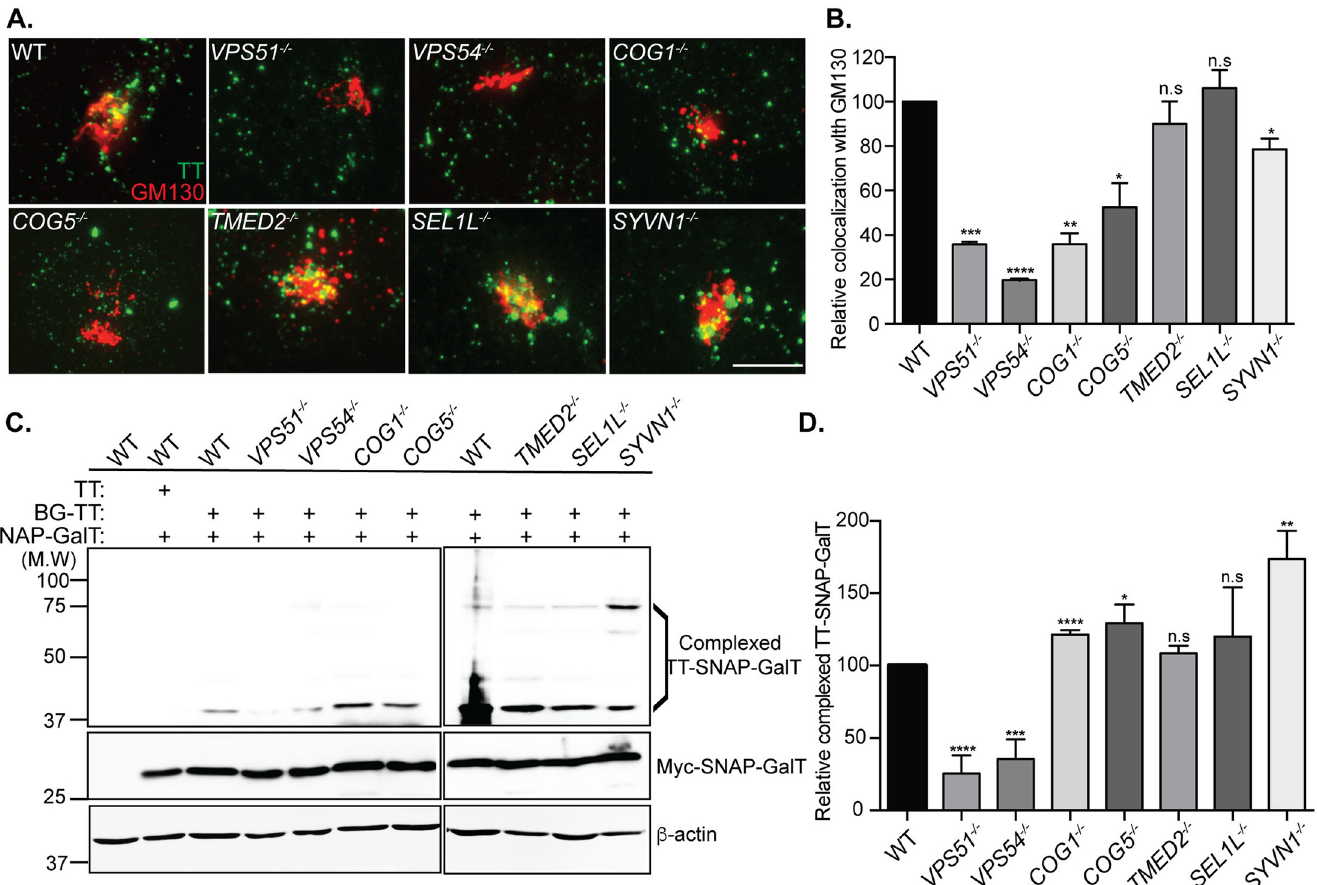
Fig 4. Characterization of typhoid toxin trafficking to the TGN in CRISPR/Cas9-edited cell lines. (A and B) Co-localization of typhoid toxin with the Golgi marker GM130. (A) Wild-type and the indicated knockout cell lines were treated with Oregon-488 labeled typhoid toxin (green) and 2 hours after toxin treatment, cells were stained with an anti-GM130 antibody (red) as described in Material and Methods. Scale bar, 5 μ m. (B) The co-localization between typhoid toxin and GM130 was determined as described in Material and Methods. Values represent the relative co-localization (normalized to wild type) and are the mean ± SEM of three independent experiments. ���� p < 0.0001, ��� p < 0.001, �� p < 0.01, and � p < 0.05; two-tailed Student’s t-test. (C and D) Typhoid toxin Golgi localization determined by SNAP- capture. (C) Cells expressing Myc-epitope tagged SNAP-GalT (Myc-SNAP-GalT) were incubated with BG-labeled typhoid toxin for 6 hr and subsequently analyzed by Western blot with an anti-Myc antibody to detect typhoid toxin/SNAP-GalT chimeric protein complexes (TT-SNAP-GalT) and anti β -actin antibody as a loading control. The migration position of the uncomplexed (Myc-SNAP-GalT) and toxin complexed GalT-SNAP (TT-SNAP-GalT) are indicated. (D) Relative amounts of TT-SNAP-GalT quantified from the blots as indicated in Materials and Methods. Values represent the relative intensity of all bands associated with TT-SNAP-GalT (normalized for loading and relative to the values of wild type, which were considered 100) and are the mean ± SEM of 3 independent determinations. ���� p < 0.0001; ��� p < 0.001; � p < 0.05; n. s.: differences not statistically significant; two-tailed Student’s t-test.